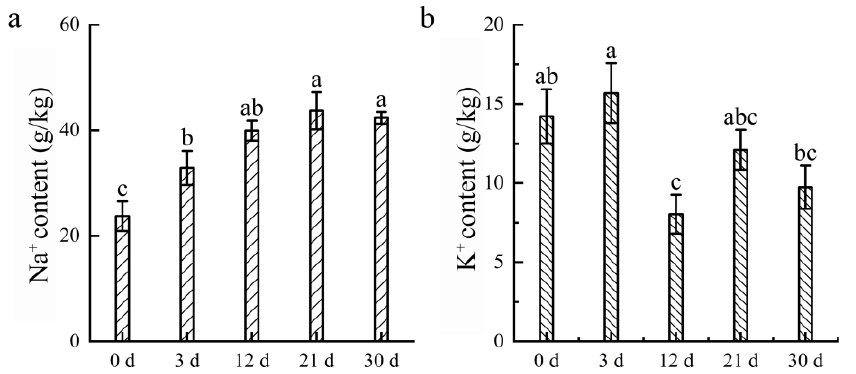
Figure 5. Na + and K + ion concentrations in water lily roots under high-salinity conditions. ( a ) Na + content. ( b ) K + content. Water lilies were cultivated in a solution containing 150 mM NaCl for 0, 3, 12, 21, and 30 days. Data are mean ( ± SD), n = 3. Different letters above bars indicate significant differences ( p < 0.05, Duncan’s test).